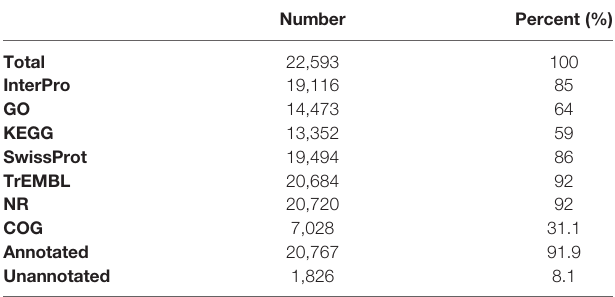
TABLE 6 | The functional annotation statistics for the predicted protein-coding